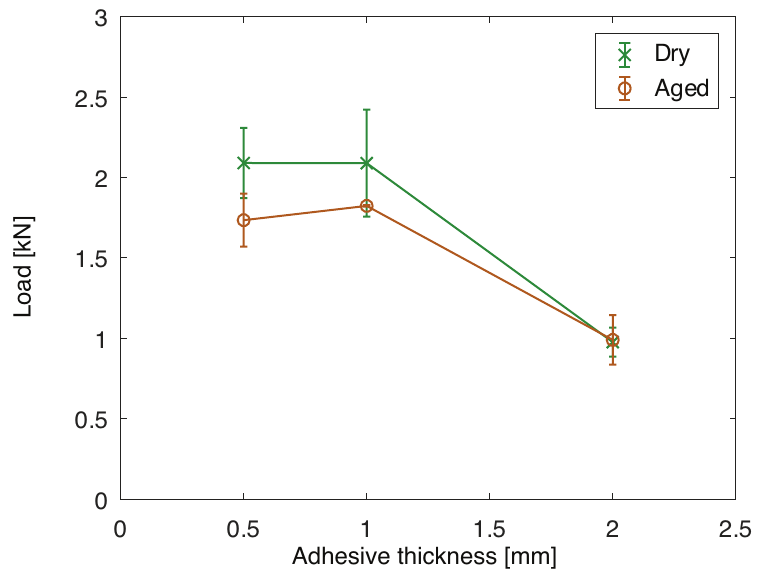
Figure 20. Maximum load for single lap joint tests for joints with PBT-GF30 substrates as a function of the adhesive thickness, dry and after aging at 70 ◦ C for two months.